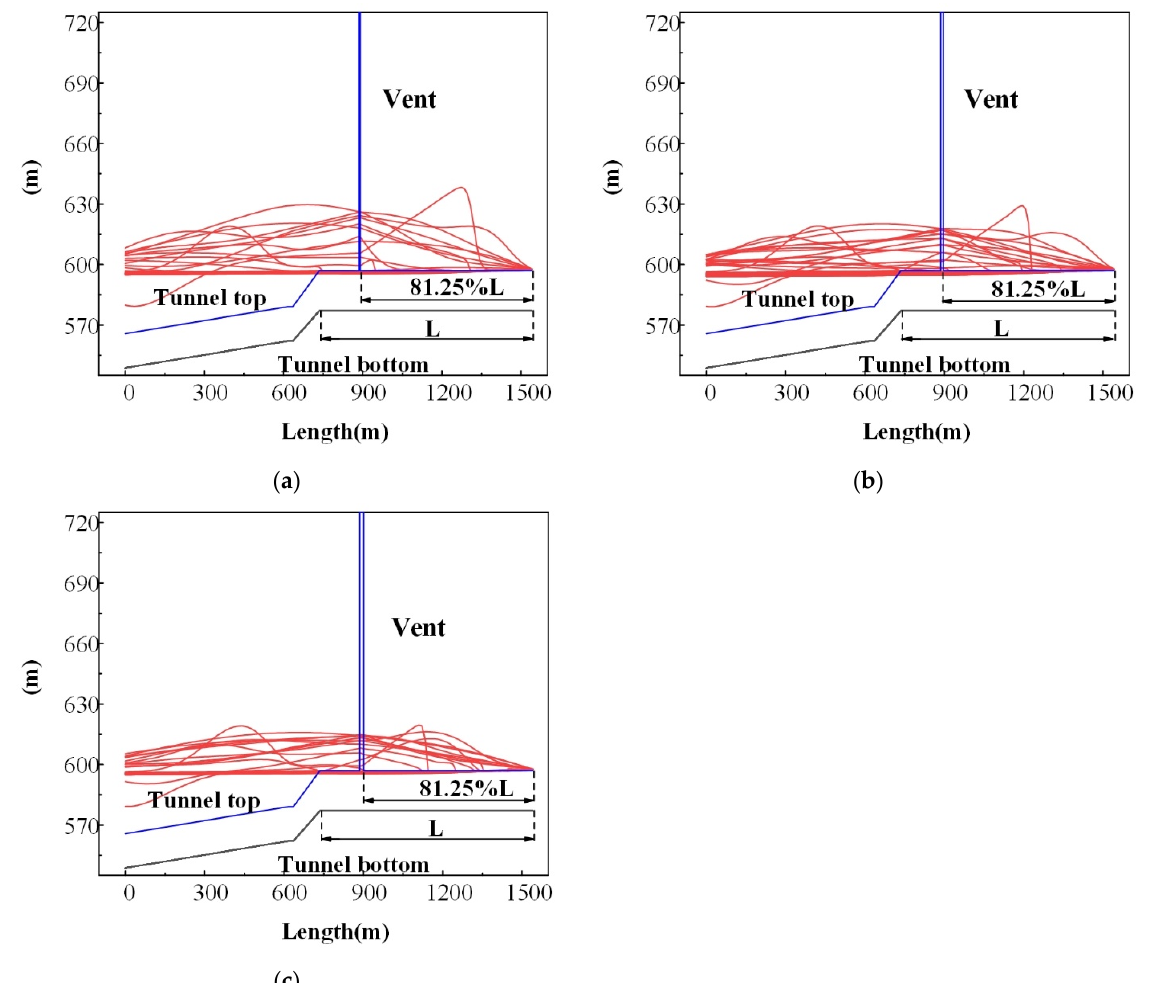
Figure 5. Water level with different vent diameters: ( a ) vent diameter of 5 m, ( b ) vent diameter of 10 m, and ( c ) vent diameter of 15 m.